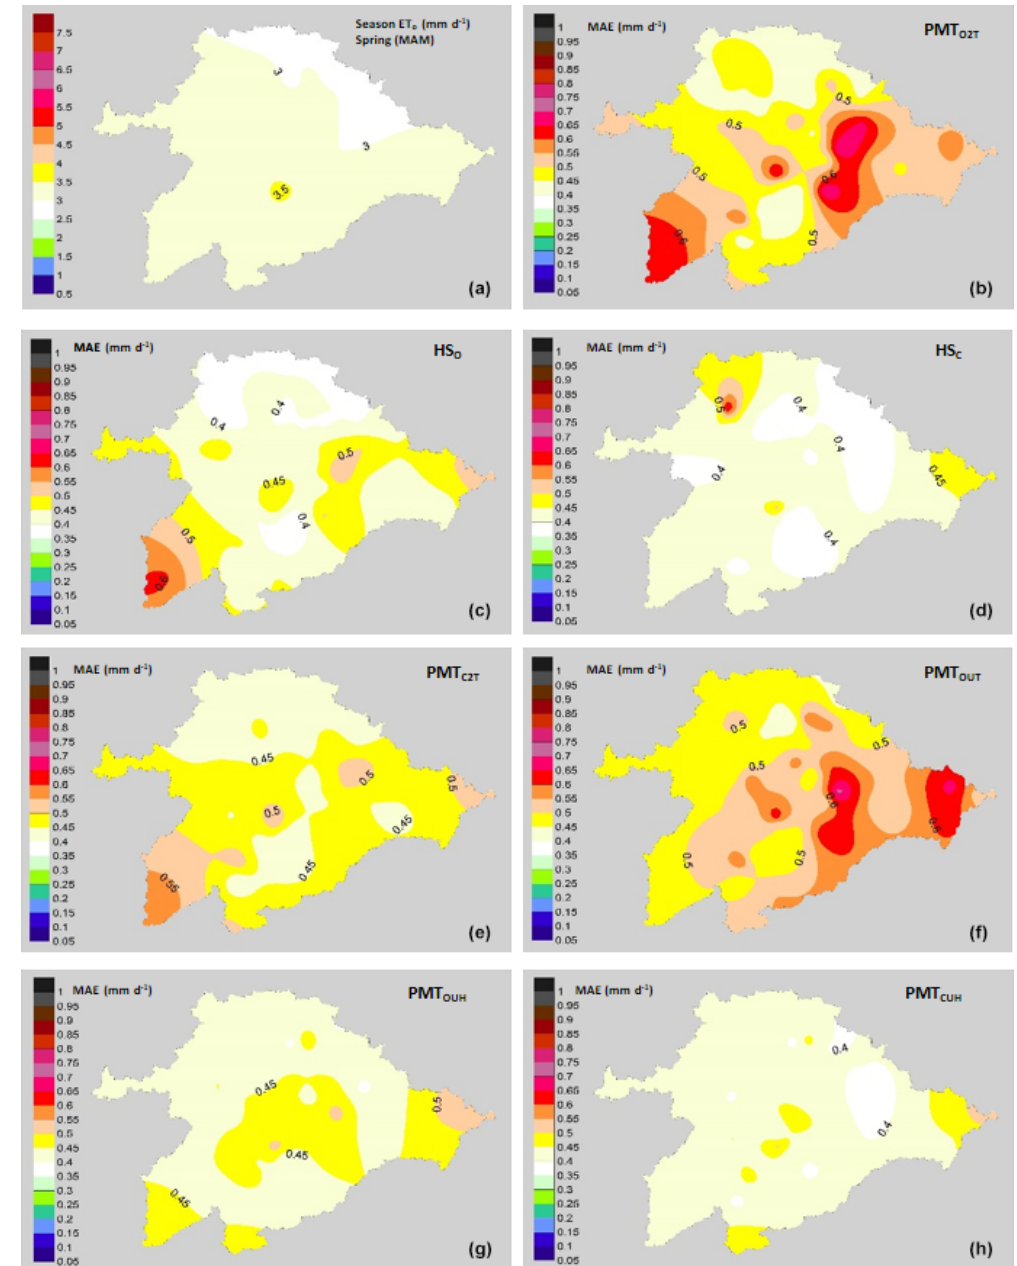
Figure 5. Performance of the models with a spring focus (March, April and May). (a) Average annual values of ET o (mmd − 1 ) in spring. Mean values of MAE (mmd − 1 ): (b) PMT O2T model, (c) H O model, (d) H C model, (e) PMT C2T model, (f) PMT OUT model, (g) PMT OUH model and (h) PMT CUH